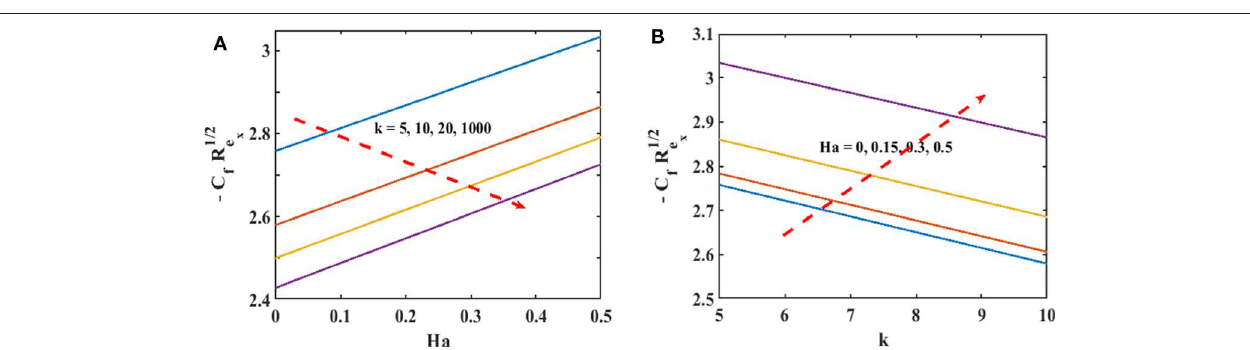
FIGURE 6 | (A) Effects of k on surface drage force. (B) Effect of Ha on surface drag